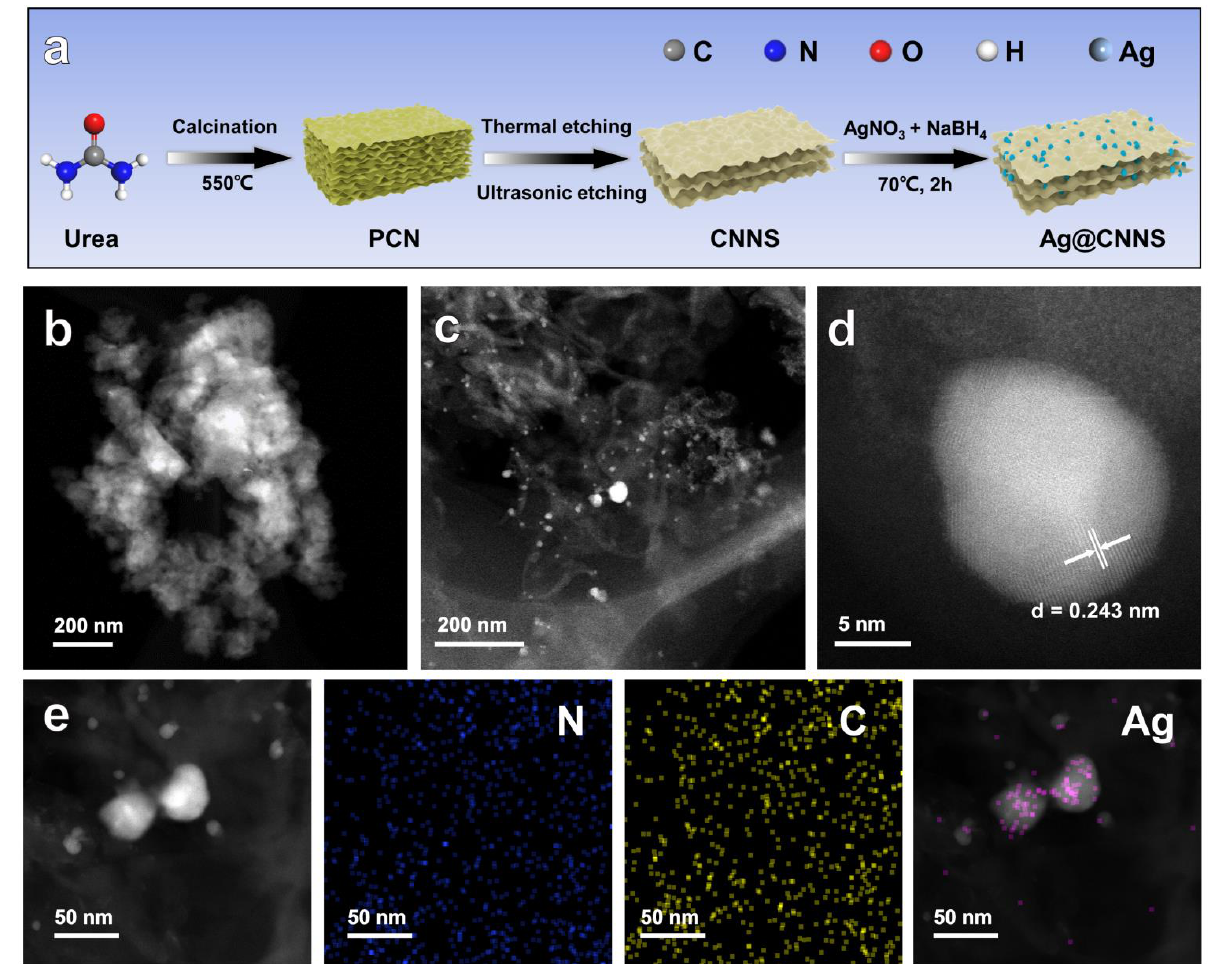
Figure 1. ( a ) Schematic illustration of the preparation process of Ag@CNNS; TEM images of ( b )